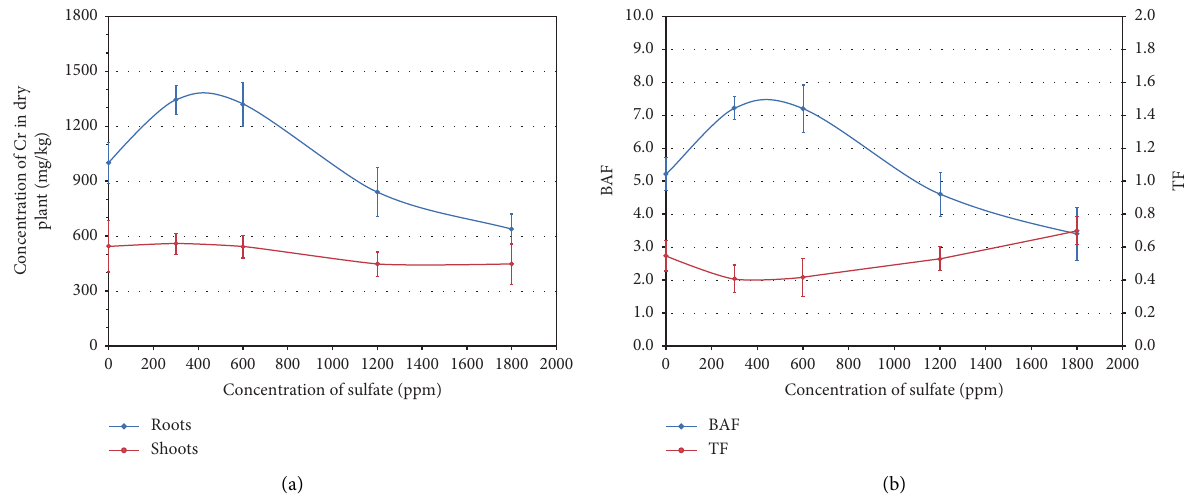
Figure 5: (a) Change in concentration of chromium in the roots and shoots and (b) change in bioaccumulation and translocation factors of P. oleracea at different concentrations of sulphate in the soil (mean of six replicates ± SE, 95%